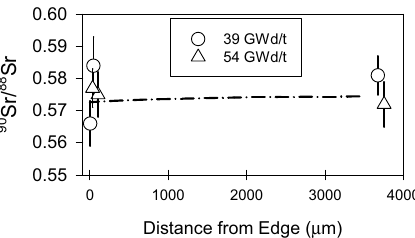
Figure 7. Measured 90 Sr/ 88 Sr (symbols) and pin cell model prediction (line). Uncertainties on the measured values are 1σ. The pin cell model predictions for 39 and 54 GWd/t are nearly identical so only one is shown (39 GWd/t). The pellet center is at 4000 μm, the edge is at